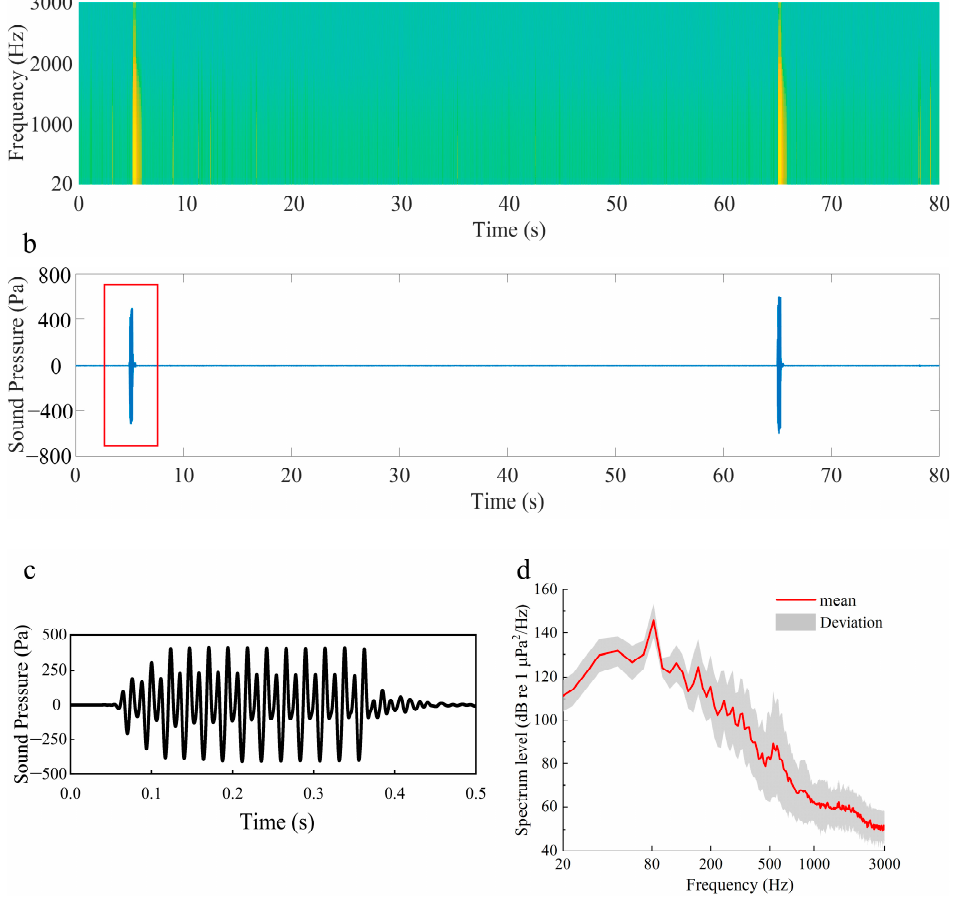
Figure 3. Spectrogram ( a ) and oscillogram ( b ) of representative fast drum trains in Chinese bahaba. ( c ) Oscillogram for representative single fast drum trains and ( d ) power spectra for the total calling signals.